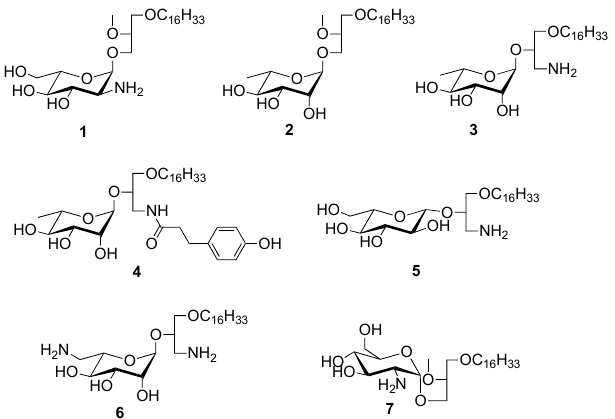
Figure 1. Reference and newly synthesized compounds used in this study. Compound 1 is reference L ‐ GAEL, Compounds 2 – 6 are newly synthesized L ‐ sugar ‐ derived GAELs, and compound 7 is reference D ‐ GAEL.